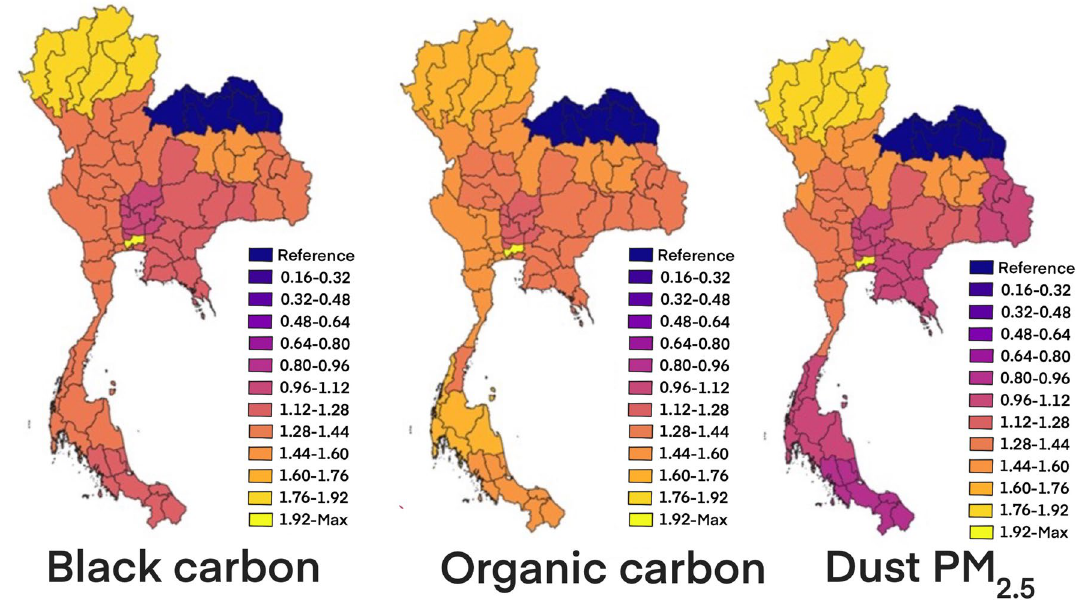
Figure 8. Ecological regression: posterior mean value for black carbon, organic carbon and dust-PM 2.5 for IRR of colon cancer at the health region level in 2017. (The maps were generated by QGIS software: a free and open source geographic information system. https